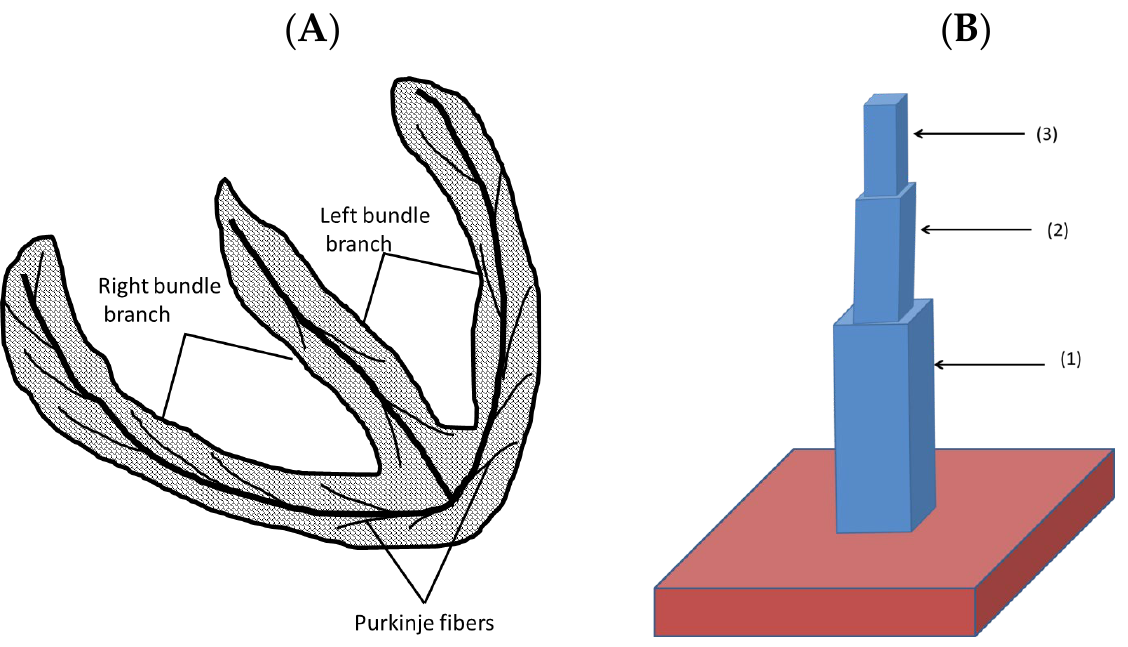
Figure 5. ( A ) The 1-D structure that extends from the atrioventricular bundle. ( B ) The computational approach representing a trabecula attached to the ventricular wall.